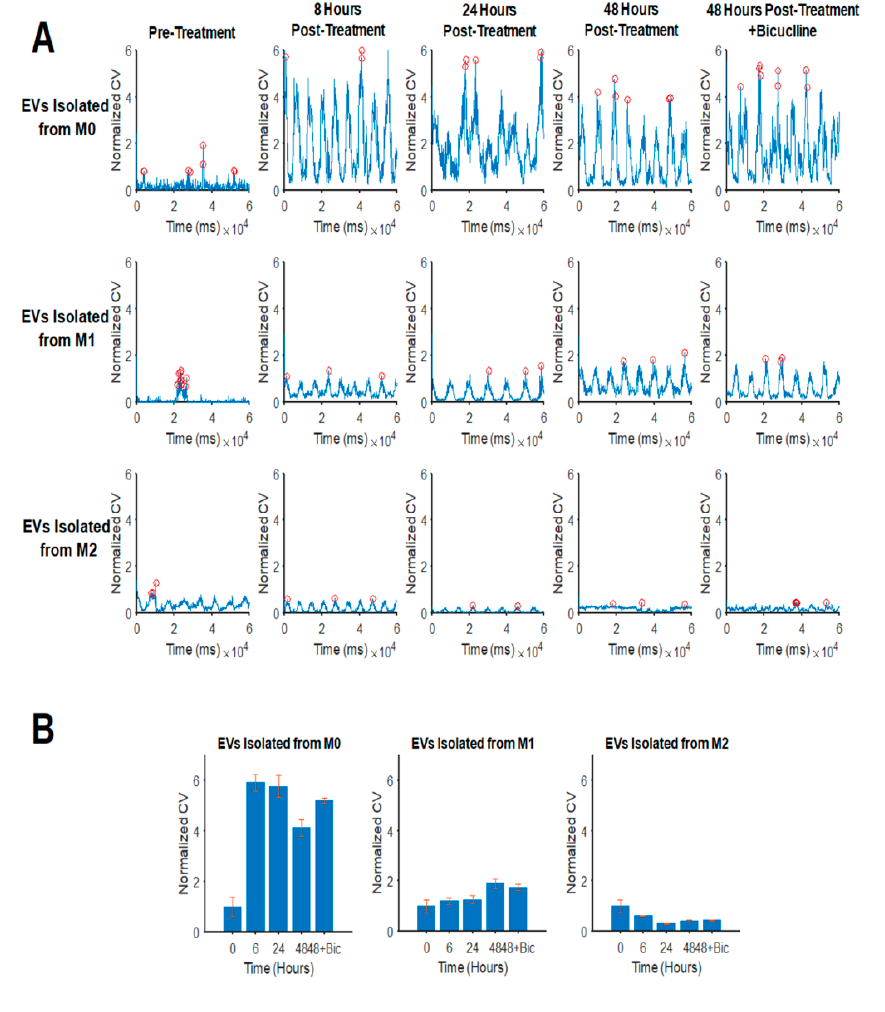
Figure 6. E ff ect of EVs isolated from M0, M1, and M2 on the neuronal conduction velocity (CV). ( A ) EVs isolated from M1 and M2 cells inhibit neuronal CVs. Conduction velocities were calculated and quantified using 60 simultaneous recordings. As depicted here, the maximum CV decreased upon treatment with M2-derived EVs, as opposed to M1-derived and M0-derived EVs. Bicuculline was added to neurons at 48 h posttreatment for 20 min to determine whether the M2-EV-induced loss of conduction velocity could be (partially) restored as the GABA A receptors are inhibited. ( B ) The quantifications of the peak conduction velocities for the experimental conditions indicate the adverse e ff ect of M1- and M2-derived EVs on neuronal CVs over the course of 48 h posttreatments. ( n = 3).